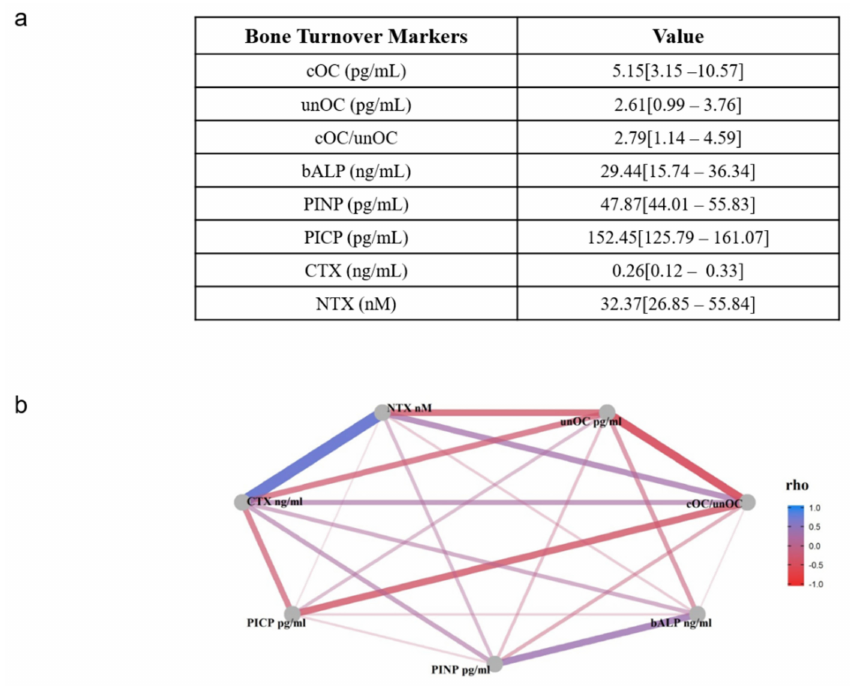
Figure 1. BTM serum levels and correlation network analysis (CNA). Panel ( a ) shows descriptive statistics for continuous patients’ characteristics expressed as the median and 1st and 3rd quartile. Panel ( b ) graphs the correlation network using the Spearman correlation coefficient (rho) between all variables included in the study. Bone-specific alkaline phosphatase (bALP); procollagen type I N-terminal propeptide (PINP); procollagen type I C-terminal pro-peptide (PICP); undercarboxylated osteocalcin (unOC); carboxylated osteocalcin (cOC); cross linked N-telopeptide of type I collagen (NTX); cross linked C-telopeptide of type I collagen